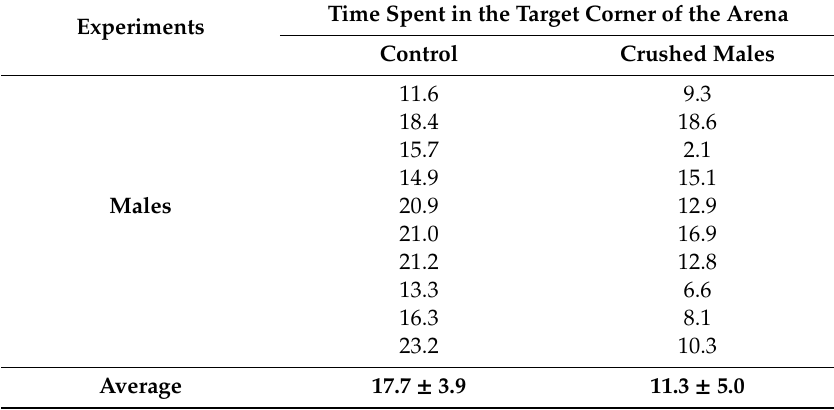
Table 4. Time any individual spent in the target corner of the arena before and after the addition of the crushed male bodies. Total observation time = 25 min, Group size = 5 individuals, N =